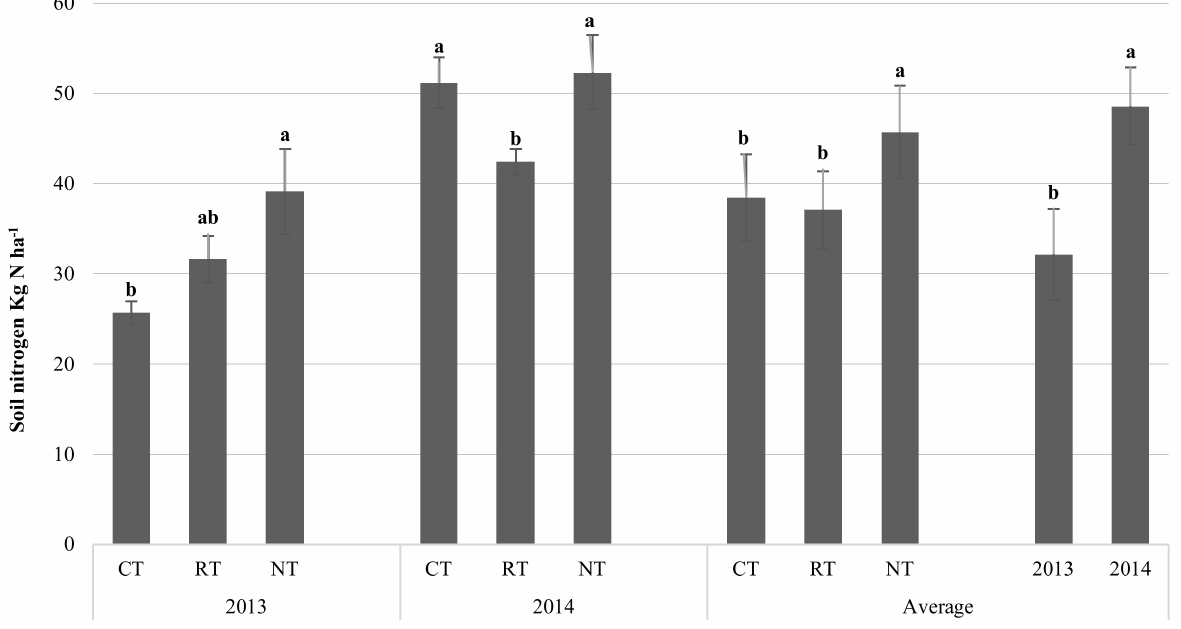
Figure 3. Soil nitrogen balance with respect to tillage system (CT—conventional; RT—reduced; NT—no tillage) and study year; 2013 and 2014 represent the 2012/13 and 2013/14 growing seasons, respectively. Different letters within each group indicate significant differences according to the Student Newman– Keuls (SNK) multiple-range test ( p ≥ 0.05). Each treatment was repeated three